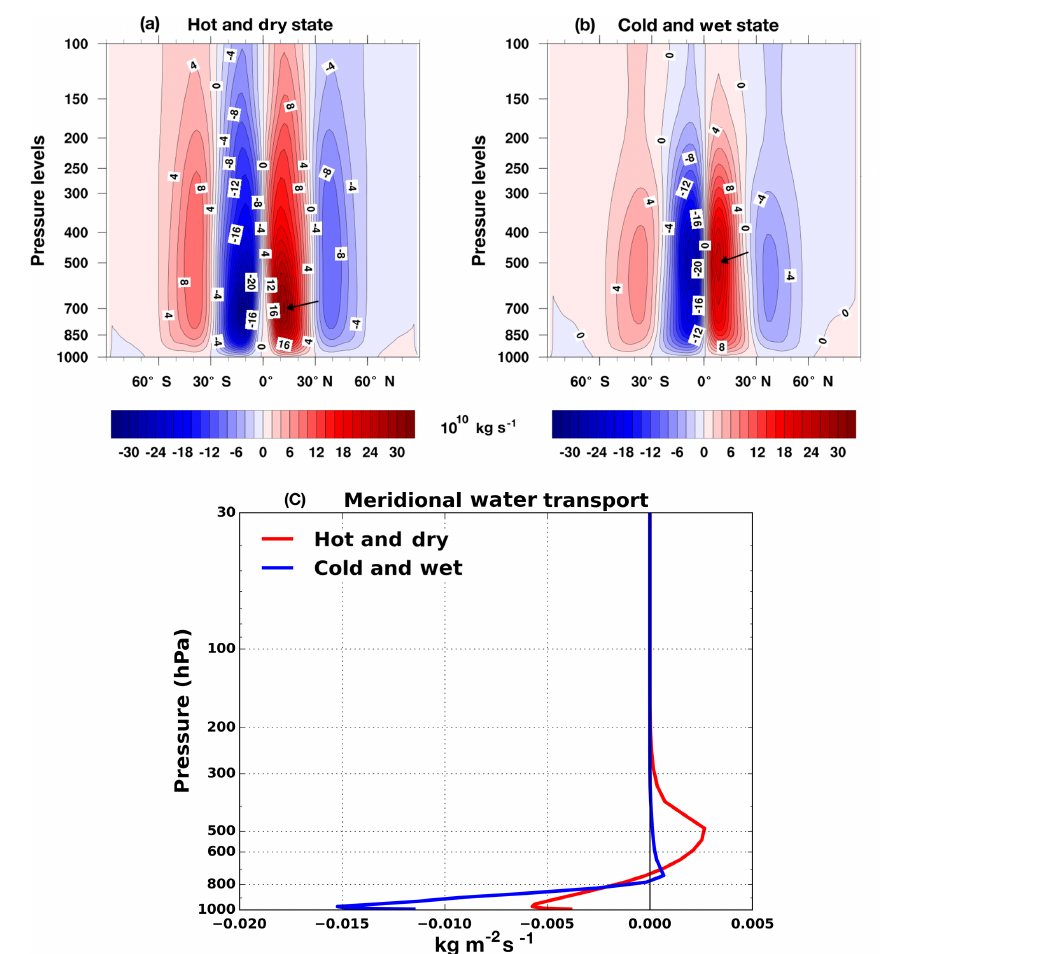
Figure 4. Annual mean behaviour of (a) and (b) meridional stream function in 10 10 kgs − 1 ; (c) vertical profiles of meridional transport of water at 10 ◦ N for the two terra-planet states in the simulations Z14 and Z15 averaged over a period of 10 years. The black arrows in (a) and (b) denote the northern Hadley circulation